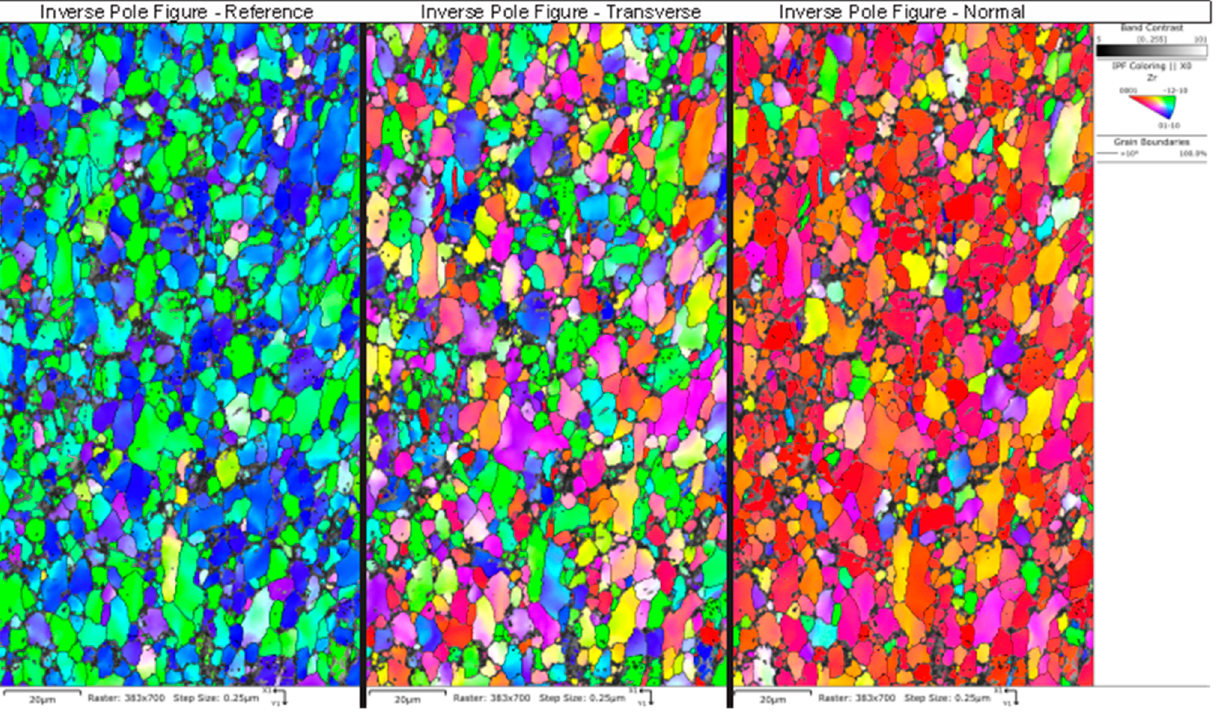
Figure 15. An example is shown of the inverse pole figures maps obtained from NPG sample a-1-05, with the inset color-legend showing the corresponding plane. The IPF map for the normal direction shows mostly red-colored grains due to the basal texture of the drawn tubes. This was consistent across all of the grains .